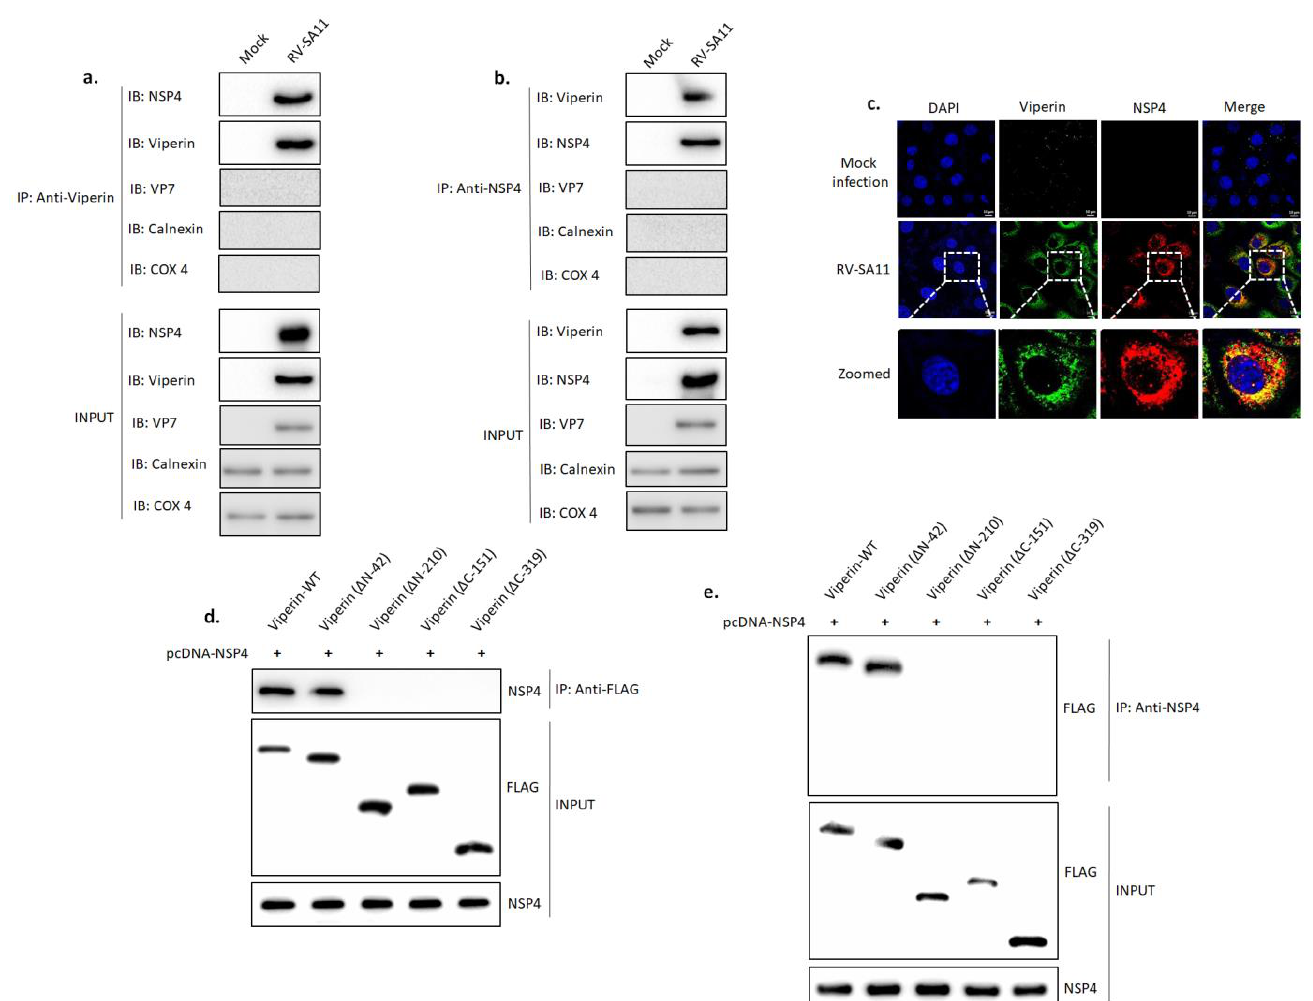
Figure 5. NSP4 interacted with viperin . ( a ) HT-29 cells were mock infected or infected with RV-SA11 at an MOI of 3.